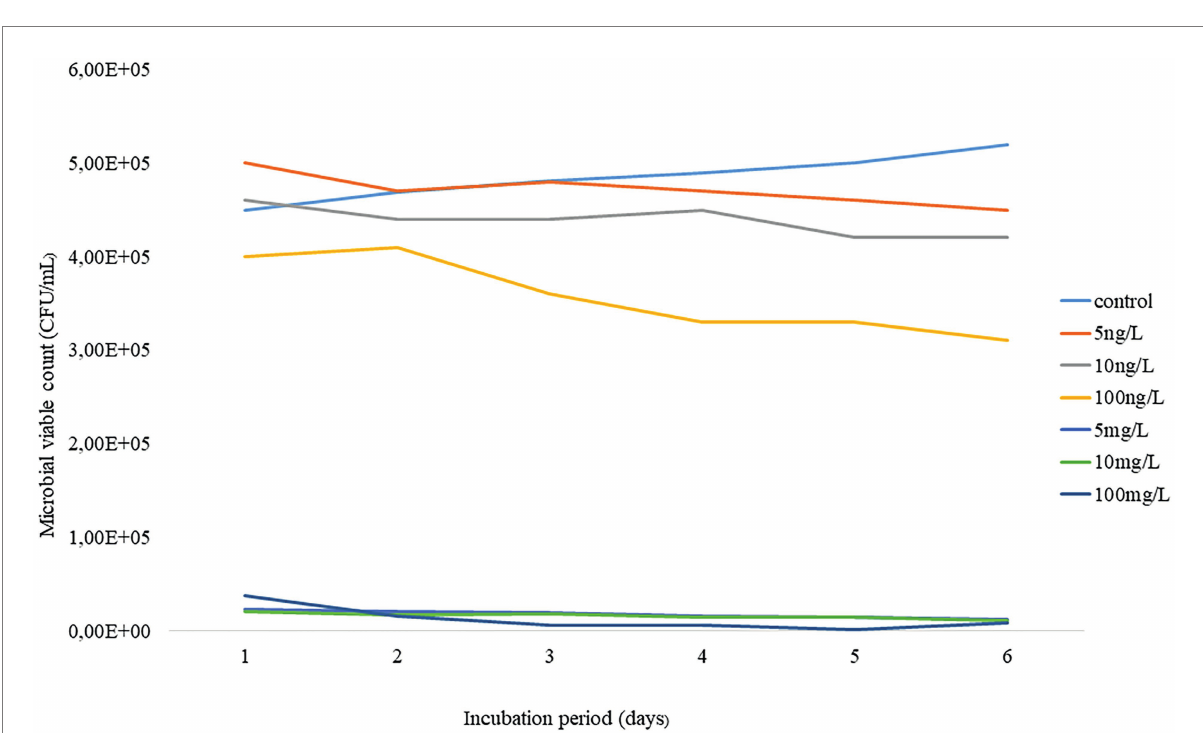
FIGURE 1 Temporal trends of AS viable bacteria under predictive elevated concentrations (5 – 100 mg/L) and environmental concentrations (5 – 100 ng/L) of EE2 over a 6-day